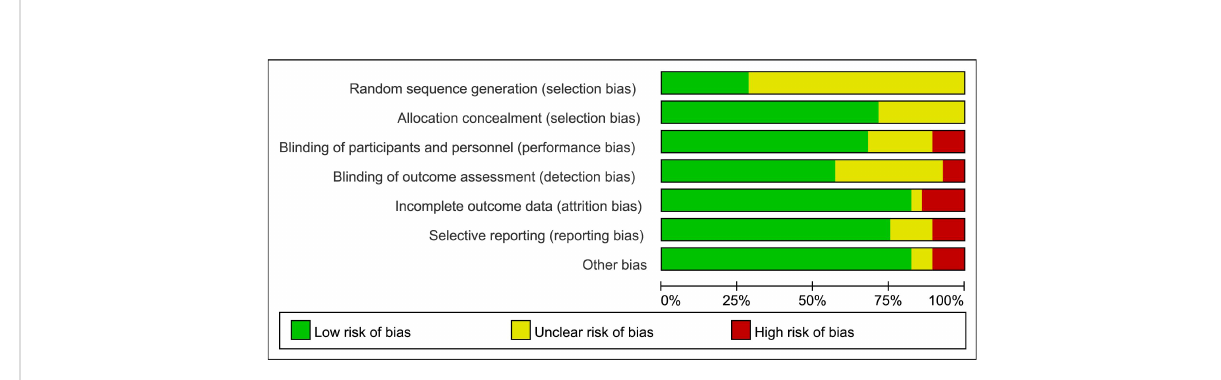
FIGURE 2 Risk of bias